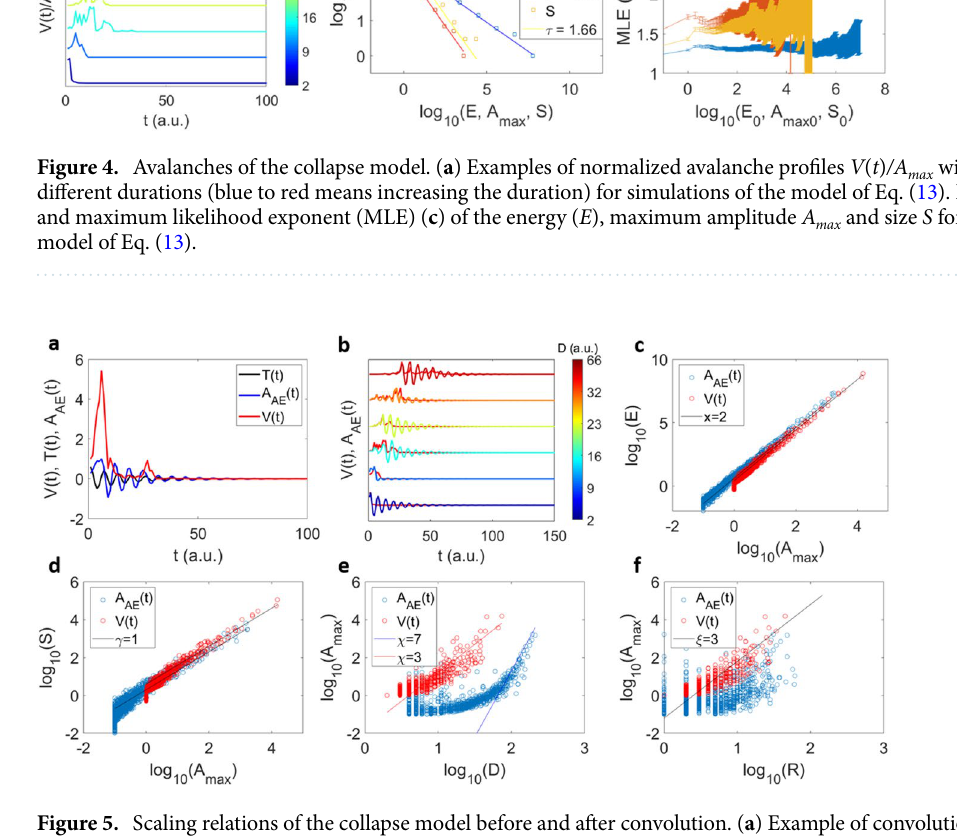
Figure 5. Scaling relations of the collapse model before and after convolution. ( a ) Example of convolution leading to A AE ( t ) with an avalanche profile V ( t ) (in red) and a transfer function T ( t ) = cos ( wt ) e − qt (in black). ( b ) Examples of 6 convoluted avalanche profiles for different source functions V ( t ) with different durations, and the same transfer function. Both convoluted and original profiles are normalized with respect to their maxima. D χ ( e ) and A max R ξ ( f ) for the original V ( t ) S A γ max ( d ), A max A x ( c – f ) scaling relations E max ( c ), ∼ ∼ ∼ ∼ profiles (red points) and after the convolution A AE ( t ) (blue